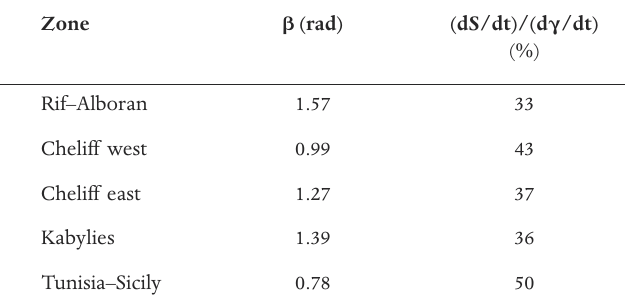
Table 3. Average strikes of the shortening component, b , with regard to the deforming zone, and derived compression-to-transcurrence ratios, (dS/dt)/(d c /dt), along the plate boundary in North Africa. Note that the maximum compression-to-transcurrence ratios are obtained for the two main bends along the plate boundary: Cheliff west and